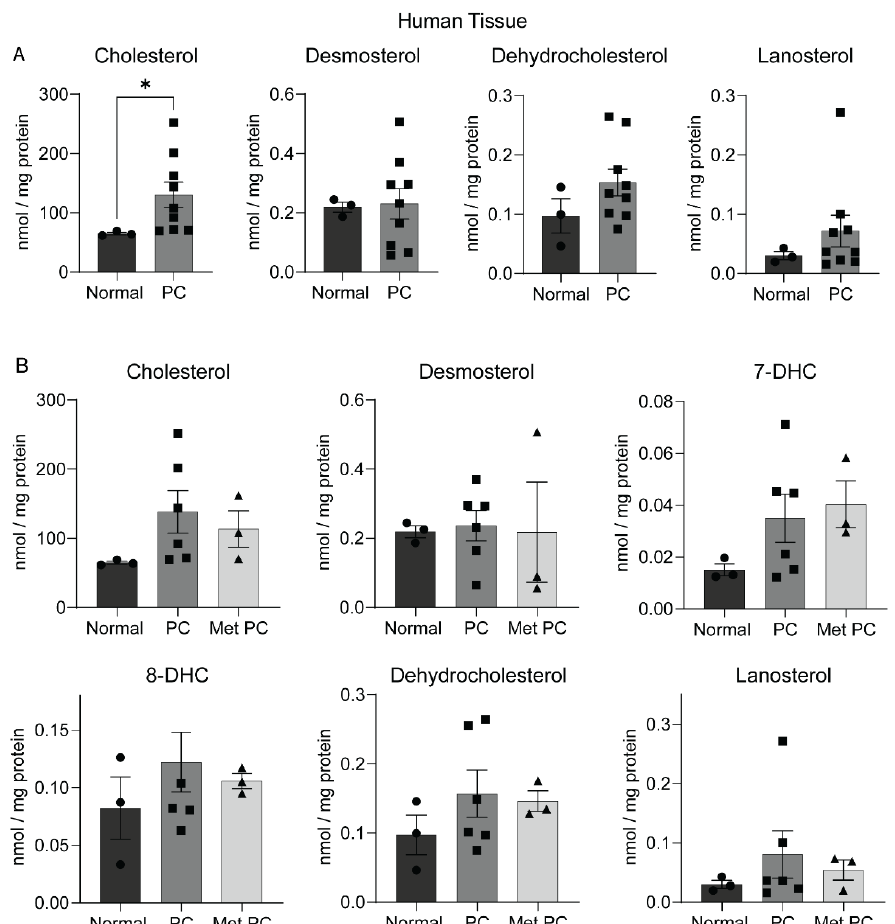
Figure 2. Sterol changes in human pancreatic tissues. ( A ) Mean and standard error plots showing sterol levels in normal human pancreatic tissues and pancreatic cancer tumors (PC) normalized with the protein content of respective tissue specimen. ( B ) Mean and standard error plots showing sterol levels in normal human pancreatic tissues, pancreatic tumors (PC), and metastatic pancreatic cancer (Met PC) tissues normalized to protein content of the respective tissue specimen. * = 0.0622, indicates significant difference in cholesterol comparing normal vs. PC obtained through Welch’s t -test.